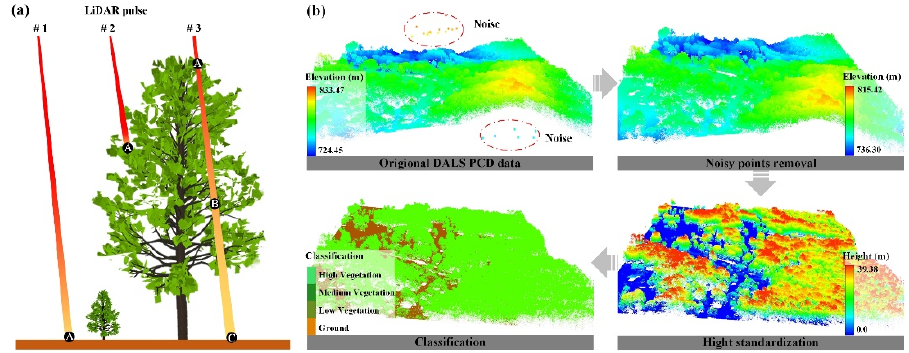
Figure 1. Conceptual diagram of DALS ( a ) and preprocessing of its PCD data ( b ). Table 1. Classification of returns based on the relationship between RNs and RN of each return.